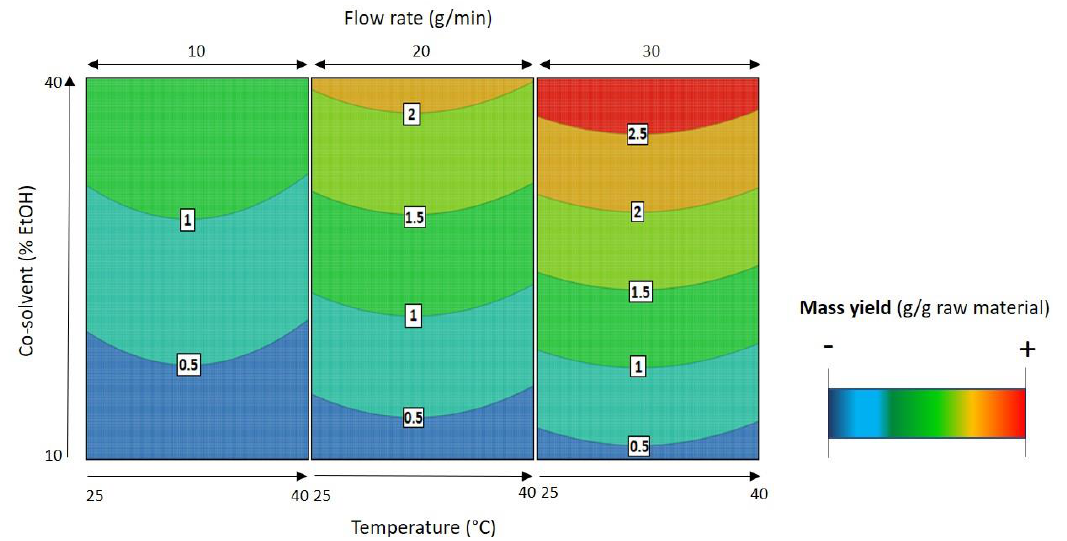
Figure 5. Response surfaces (DOE 2) fitted to the extraction mass yield (g/g raw material) as a function of temperature, co-solvent percentage (%EtOH), and flow rate. The white squares show the mass (mg) extracted depending on the conditions of the three axes. In blue, the minimum extraction; in red, the maximum mass extracted in SFE. To maximize mass yield, the best SFE is conducted at a high flow rate (30 g/min) with a high co-solvent percentage (40% EtOH).